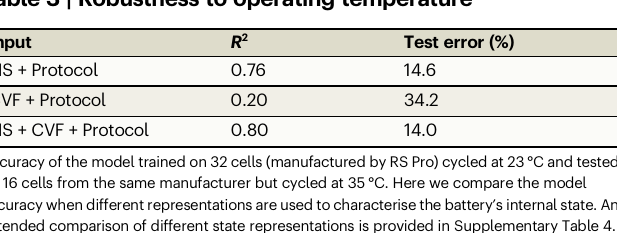
Table 3 | Robustness to operating